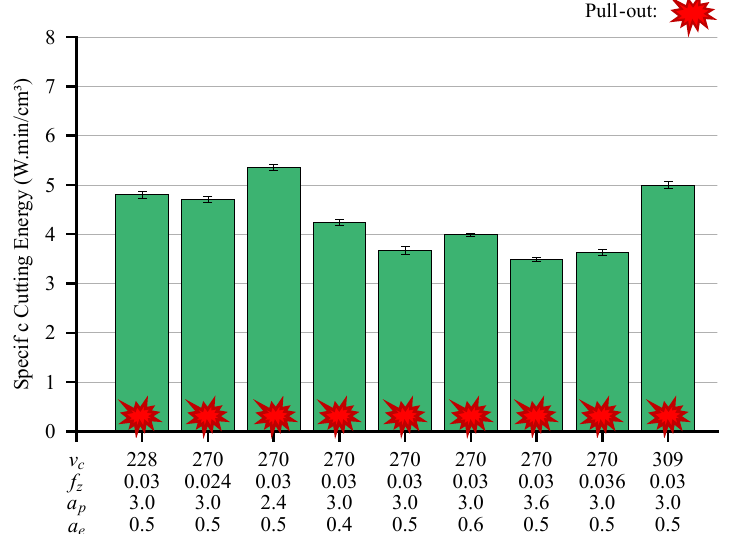
Figure 14. Qualification test of the universal tool, the evolution of W c (W · min/cm 3 ) for different v c (m/min), f z (mm/tooth), a p (mm), and a e